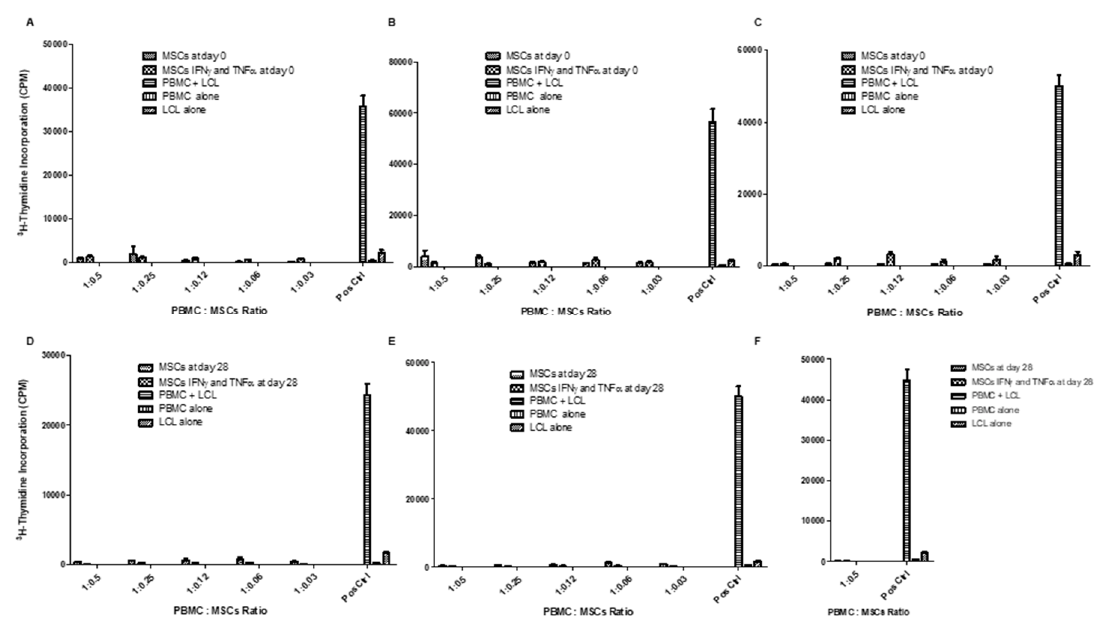
Figure 7. WJ-MSCs (Day 0) and chondro-MSCs (Day 28) showed hypo-immunogenicity even with IFN- γ and TNF- α pre-treatment. Distinct WJ-MSCs ( A–C ) and chondro-MSCs ( D–F ) primed with pro-inflammatory cytokines, or not, were used as stimulators facing HLA-mismatched PBMC at various PBMC: MSC ratios. Pre-irradiated LCL cells were used as a positive control (Pos Ctrl) to stimulate PBMC alloproliferation (PBMC + LCL). Data are expressed as mean CPM ± SD. CPM—count per